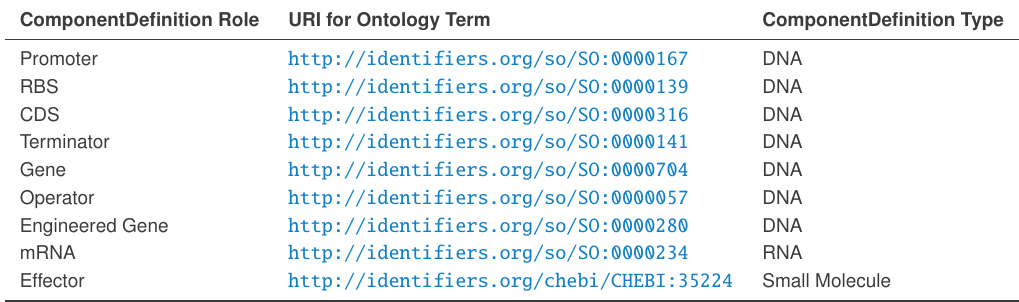
Table 3: Ontology terms to specify the roles property of a ComponentDefinition , organized by the type of ComponentDefinition to which they are intended to apply (see Table 2).